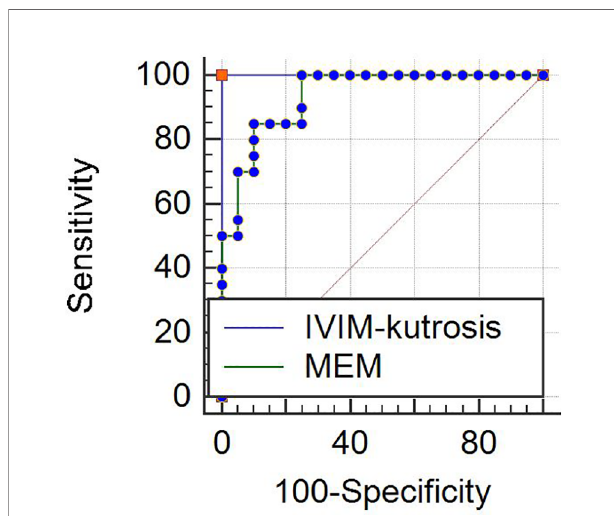
FIGURE 6 | ROC curves for the IVIM-kurtosis model (AUC = 1.000) and MEM (AUC = 0.938). No signi fi cant difference was found between the two models ( z = 1.761, P = 0.0783). Note: IVIM, intravoxel incoherent motion; MEM, monoexponential